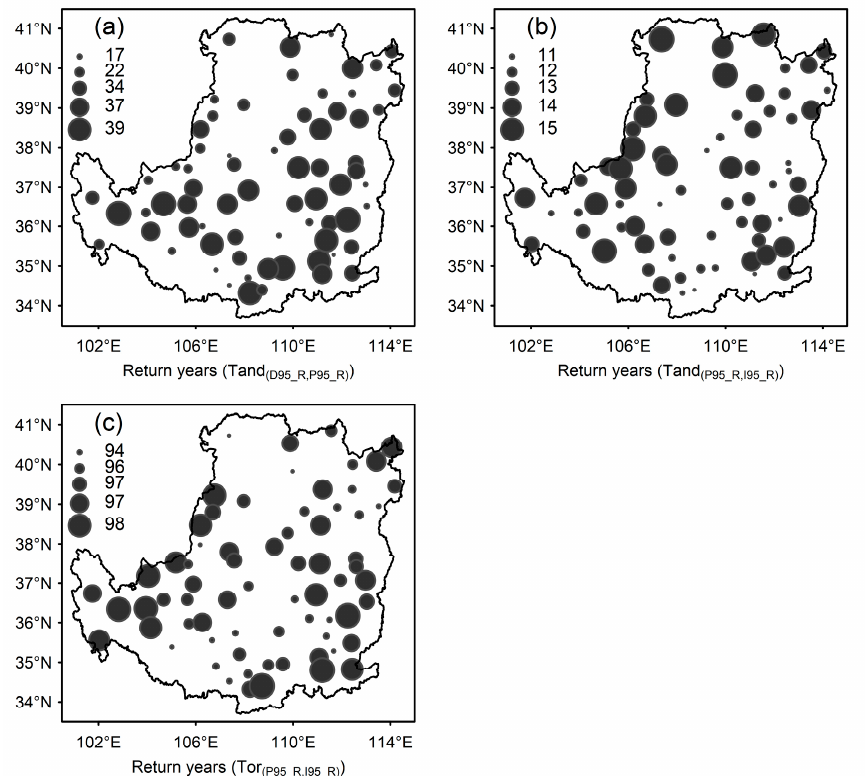
Figure 8. The univariate return period values for each individual indicator under joint return period of 50 years corresponding to three combination groups: ( a ) corresponds to the {D95_R, P95_R} event; ( b ) corresponds to the {P95_R, I95_R} event; ( c ) corresponds to the {P95_R or I95_R} event.